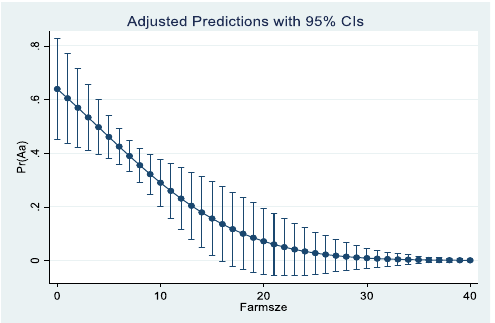
Figure 10. The non-linear impact of farm size on the probability to adopt accumulated assets as a risk management strategy